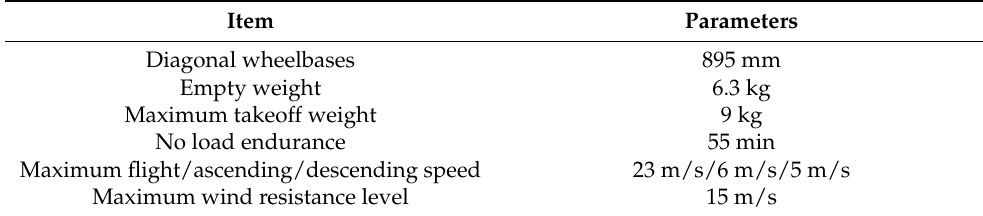
Table 1. Parameters of DJI M300 RTK.